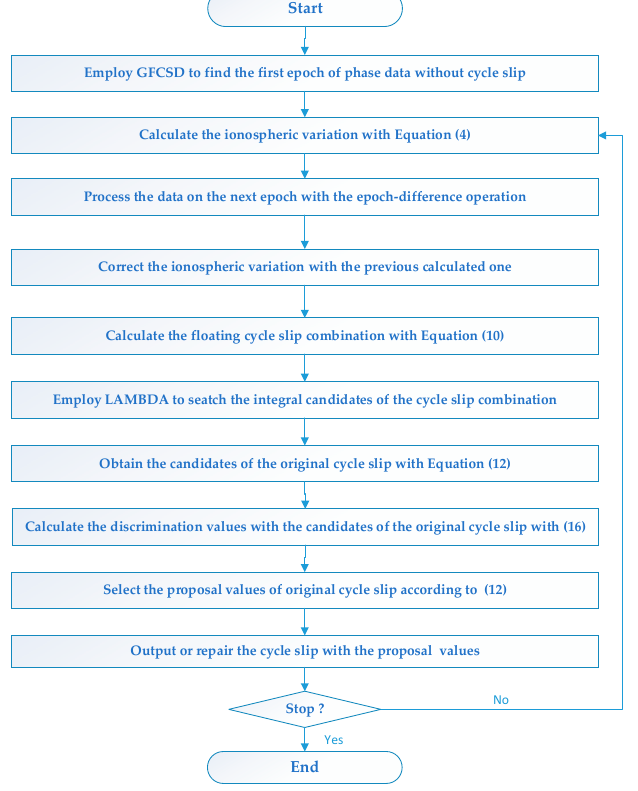
Figure 2. The process flow of the cycle ‐ slip repair (CSR) method for BDS dual ‐ frequency phases (BDCSR).